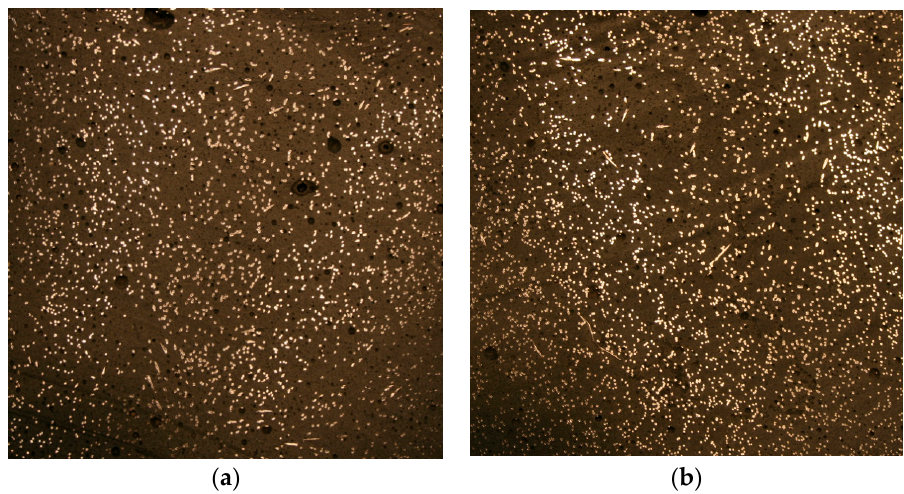
Figure 9. Images of fiber distribution for Mix 1 ( a ) at 35 mm away and ( b ) at 220 mm away.